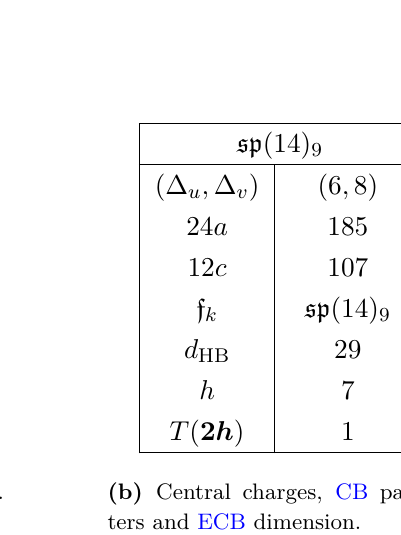
Figure 28. Information about the sp (14) 9